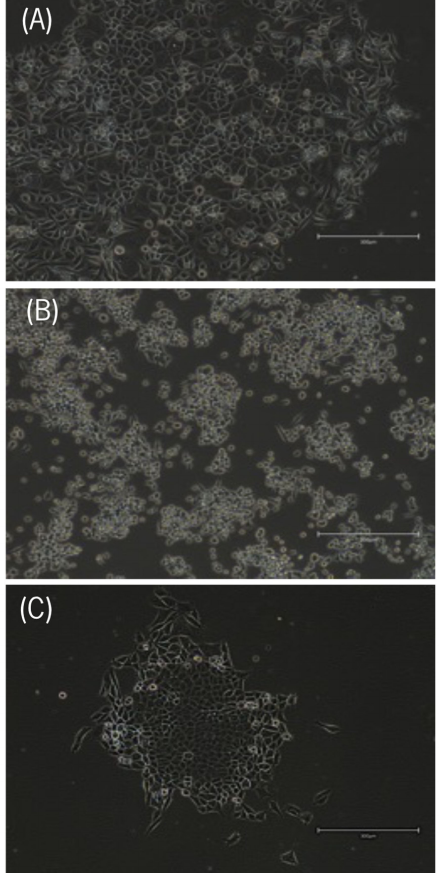
Figure 2. Morphology of the cell lines under study. ( A ) AGS cells with 90% confluence (passage 49); ( B ) MKN45 cells with 80% confluence (passage 16); and ( C ) MKN28 cells with 50% confluence (passage 4). Magnification, 20 × ; scale bars, 300 µ